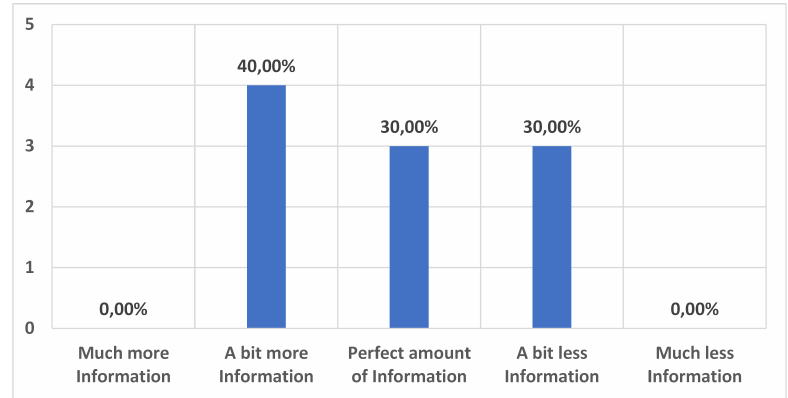
Figure 16. Suitability of the audio length. How appropriate was the length of the audio stories? Visitors would rather have had...